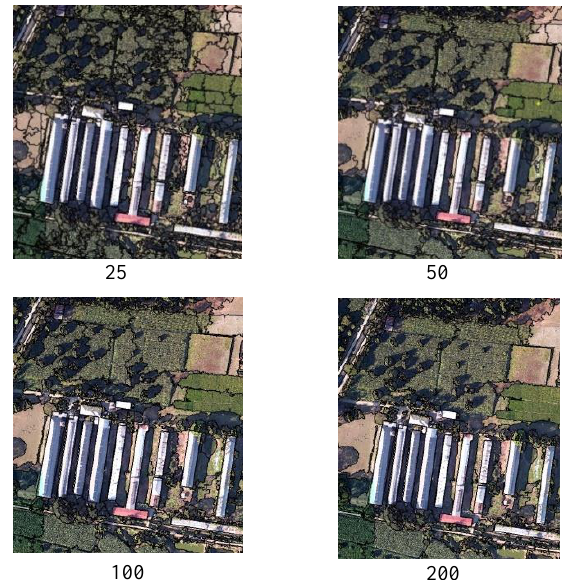
Figure 5. The different segmentation of the shadowed and non-shadowed area